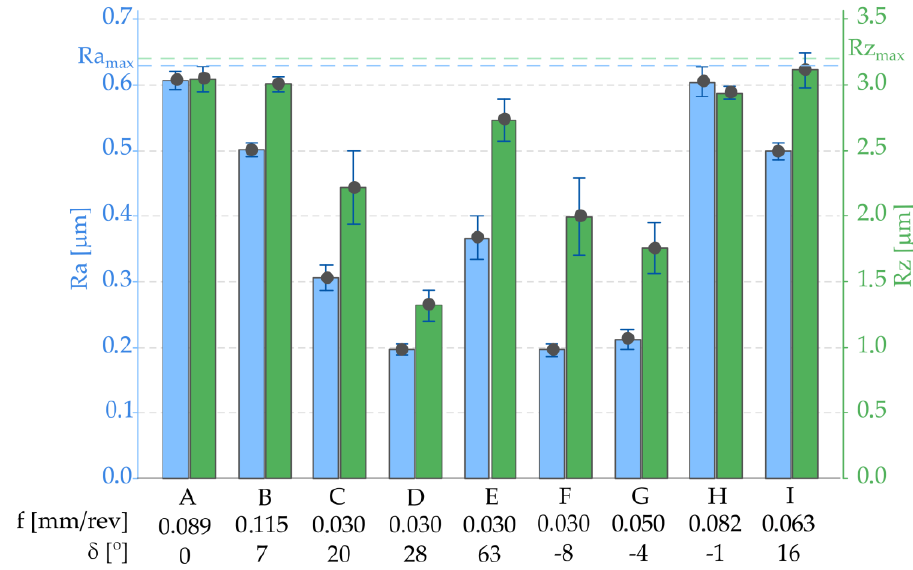
Figure 14. Graph representing the average values of the surface roughness parameters Ra and Rz in points A–I (according to Figure 13).